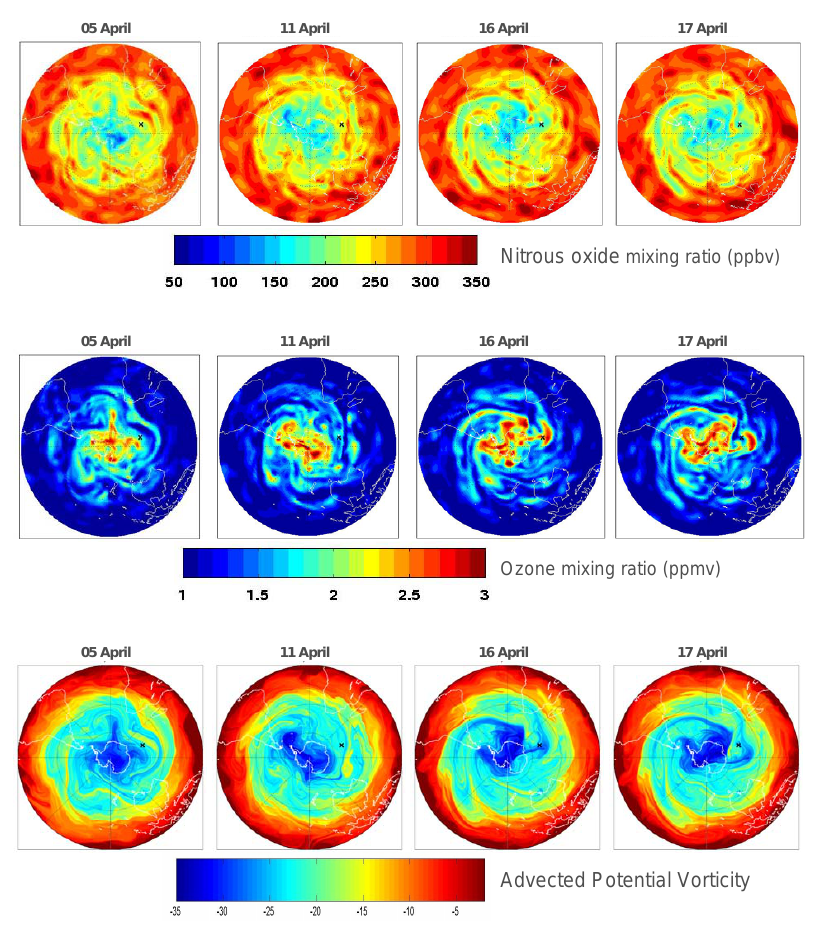
Fig. 3. The upper and intermediate panels depict maps of mixing ratios of nitrous oxide (N 2 O) (in ppbv) and of ozone (O 3 ) (in ppmv), respectively. N 2 O and O 3 data are derived from Aura/MLS observations assimilated by the MOCAGE-PALM system for selected dates: 05, 11, 16 and 17 April, in the lower stratosphere, onto the 475-K isentropic surface. Lower panel: same as for the upper and intermediate panels, but for Advected Potential Vorticity (APV) derived from the high-resolution MIMOSA model. The black cross “ × ” symbol indicates the Kerguelen location.